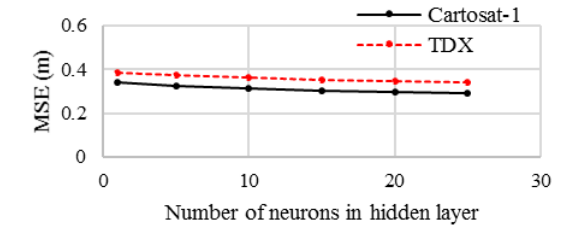
Figure 13. The performance of the NNs with adding the hidden layer and increasing the number of Neurons in the hidden layer